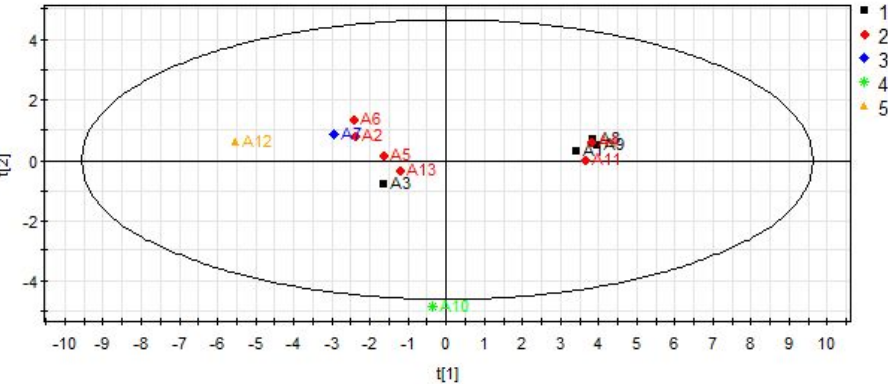
Figure 5. PLS-DA score scatter plot for samples collected from different species: (1) E. sagittatum (Sieb.et Zucc.) Maxim.; (2) E. koreanum Nakai; (3) E. wushanense T. S. Ying; (4) E. brevicornu Maxim.; (5) E. pubescens Maxim.. The denotations from numbers 1 to 13 were the corresponding sample numbers